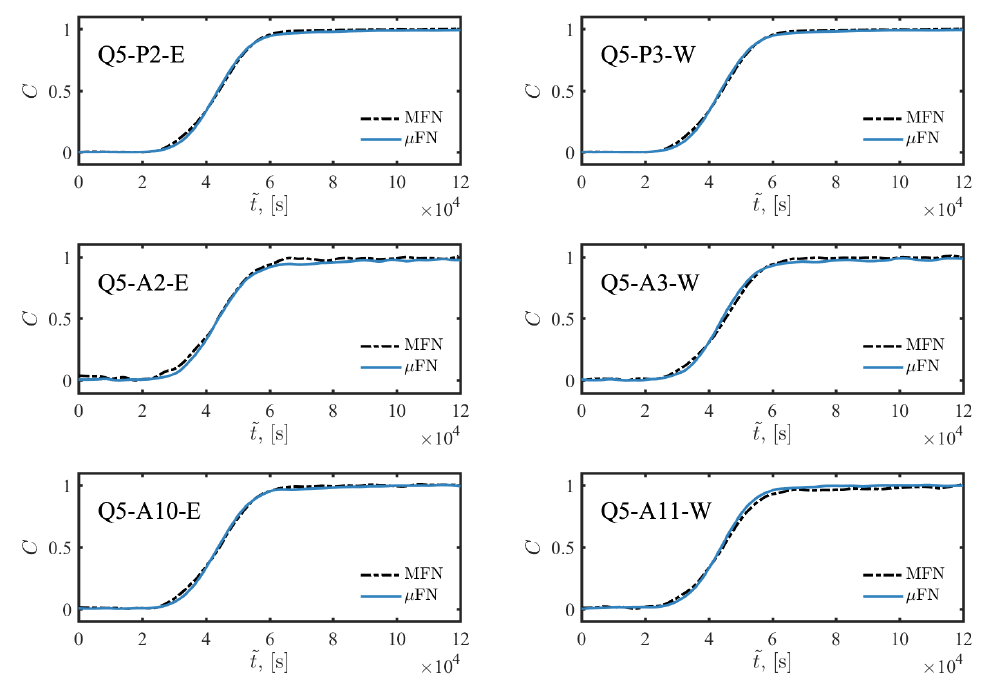
Figure A8. Breakthrough curves measured in physical time in the MFN (dashed line) and µ FN (solid line) at upstream (east) and downstream (west) locations on the same primary (P2–P3), secondary (A10–A11) and tertiary (A2–A3) fracture at Q = 5 µ L/h.